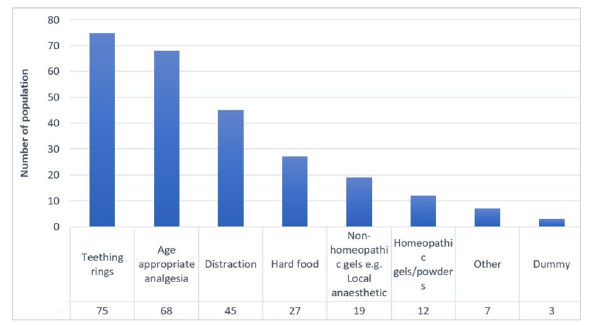
Fig. 2 Frequency of reporting for management approaches of teething symptoms by participants ( n = 80). Participants could record more than one management